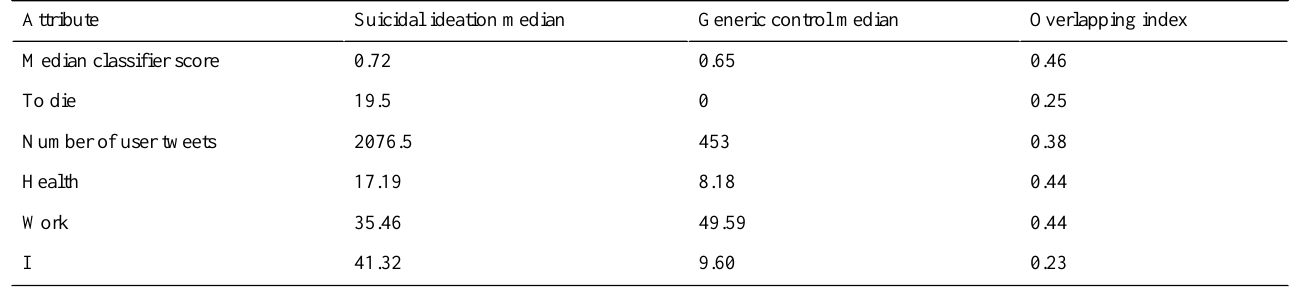
Table 7. Medians and Overlapping Index for some of the attributes with the most significant differences between the Suicidal ideation and Generic control